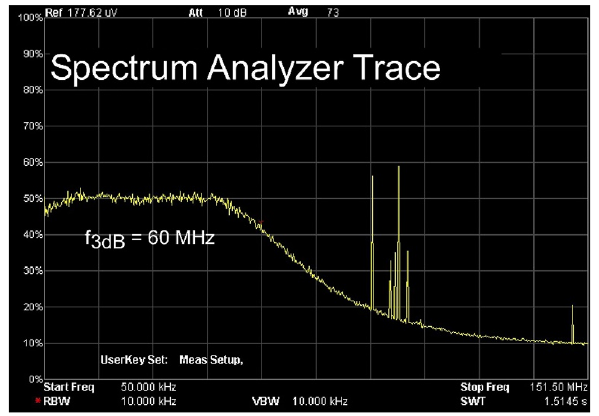
Figure 5. Spectrum analyzer trace of SiPM output. Electric spectrum analyzer trace of the SiPM output with low pass filter removed showing shot noise filtered by the system bandwidth. The transfer function is flat until 45 MHz and has a 3 dB bandwidth of 60 MHz due to the amplifier feedback capacitor. 90–110 MHz FM radio signals are detected by the unshielded detector, but have negligible total power compared to the dark noise and are removed by the low pass